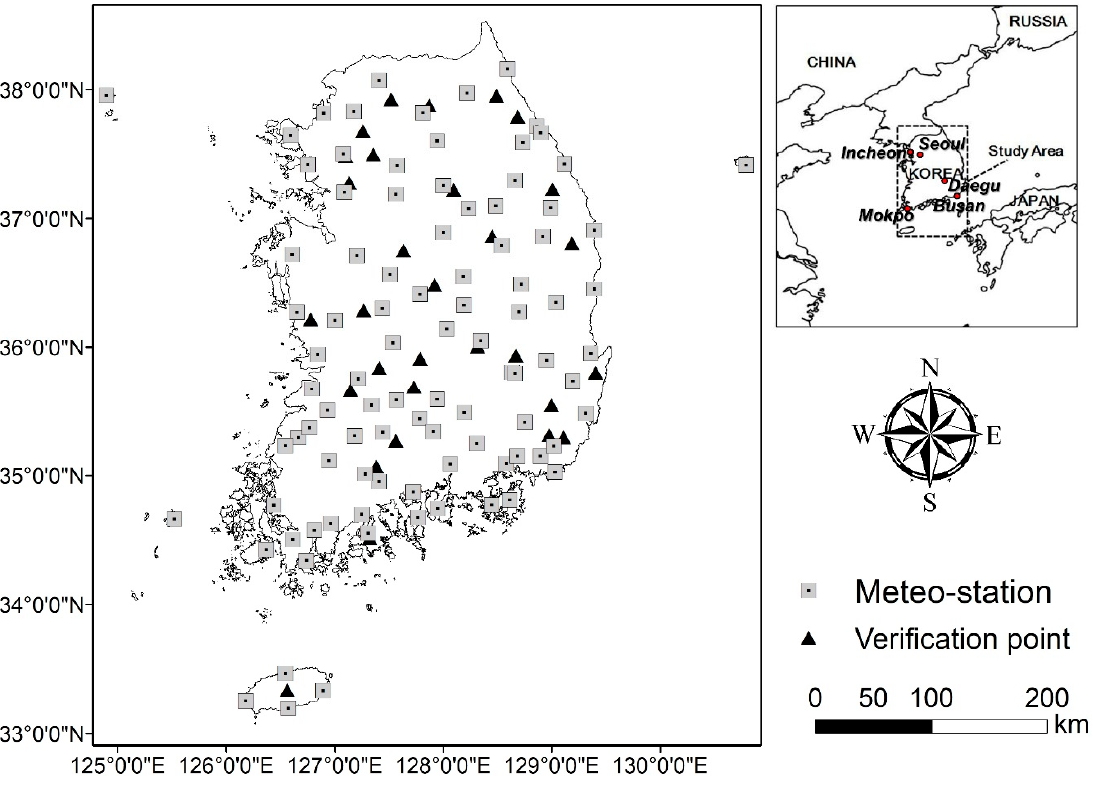
Figure 1. Map of the study area and spatial distribution of the primary sampling points. Meteo-station: Meteorological stations; Verification point: Mongolian oak ( Quercus mongolica Fisch.) forests selected for validation.